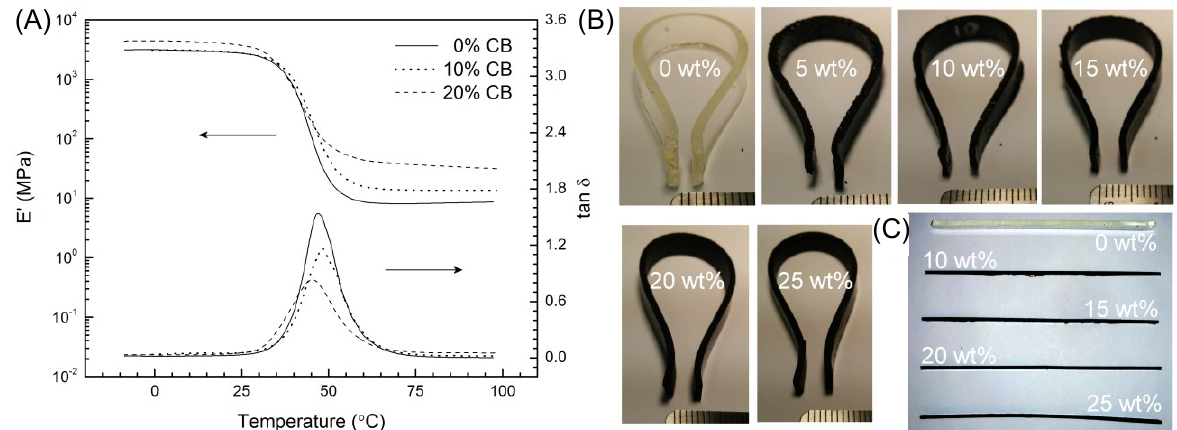
Figure 6. ( A ) Dynamic mechanical analysis (DMA) curves for various levels of CB-doped SMP. The SMP ( B ) shape-fixing and ( C ) shape-recovery properties are minimally affected by carbon doping, demonstrated using initially-straight material